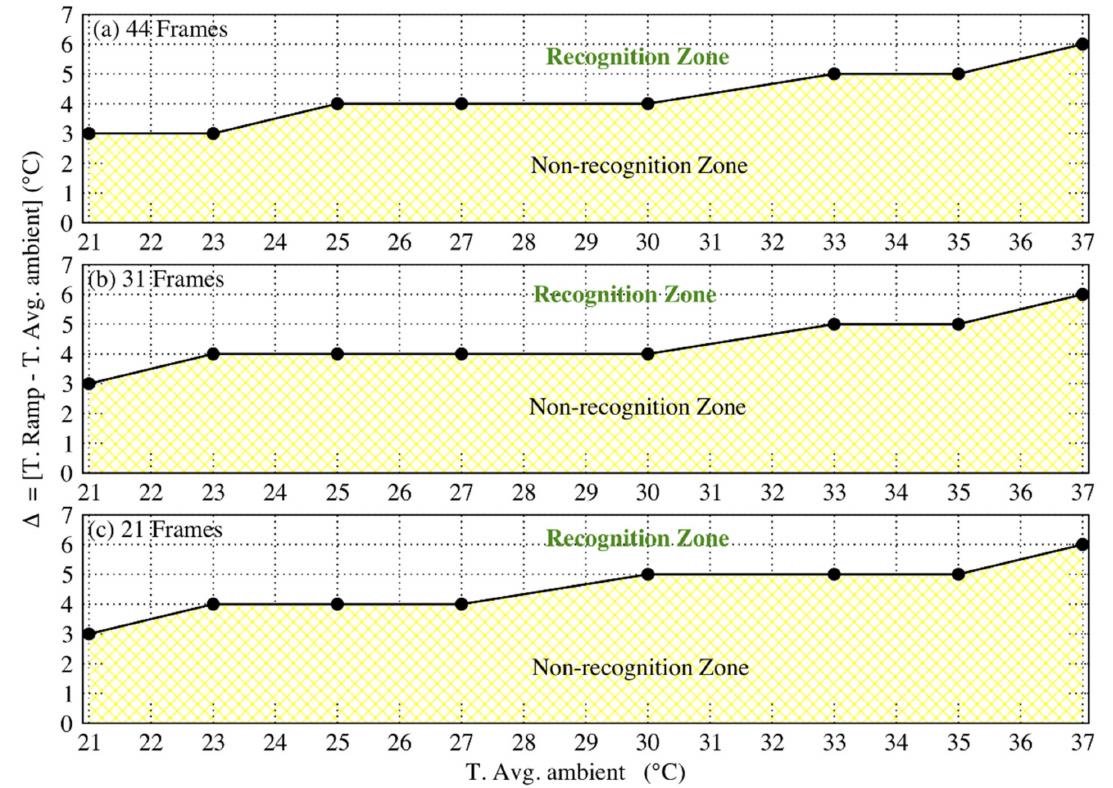
Figure 11. Plot of delta ( ∆ ) Vs Average ambient temperature (T. Avg. ambient): ( a ) normal pace, 44 frames; ( b ) brisk pace, 31 frames; ( c ) running pace, 21 frames. The recognition and non-recognition zones are shown for each of these